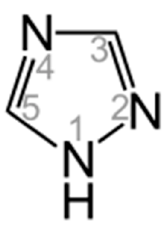
Figure 3. The position of the nitrogen atoms in the 1,2,4-triazole compounds.